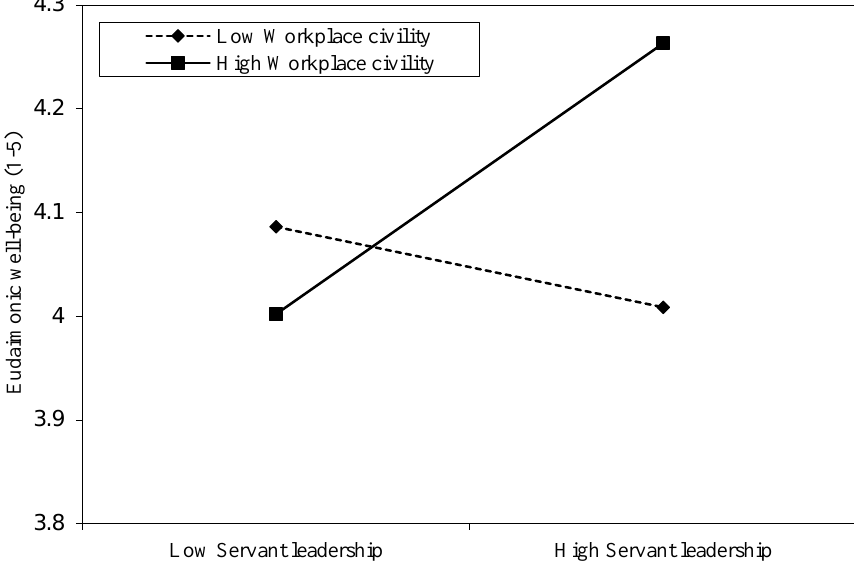
Figure 1. The moderating role of workplace civility in the relationship between servant leadership and EWB.